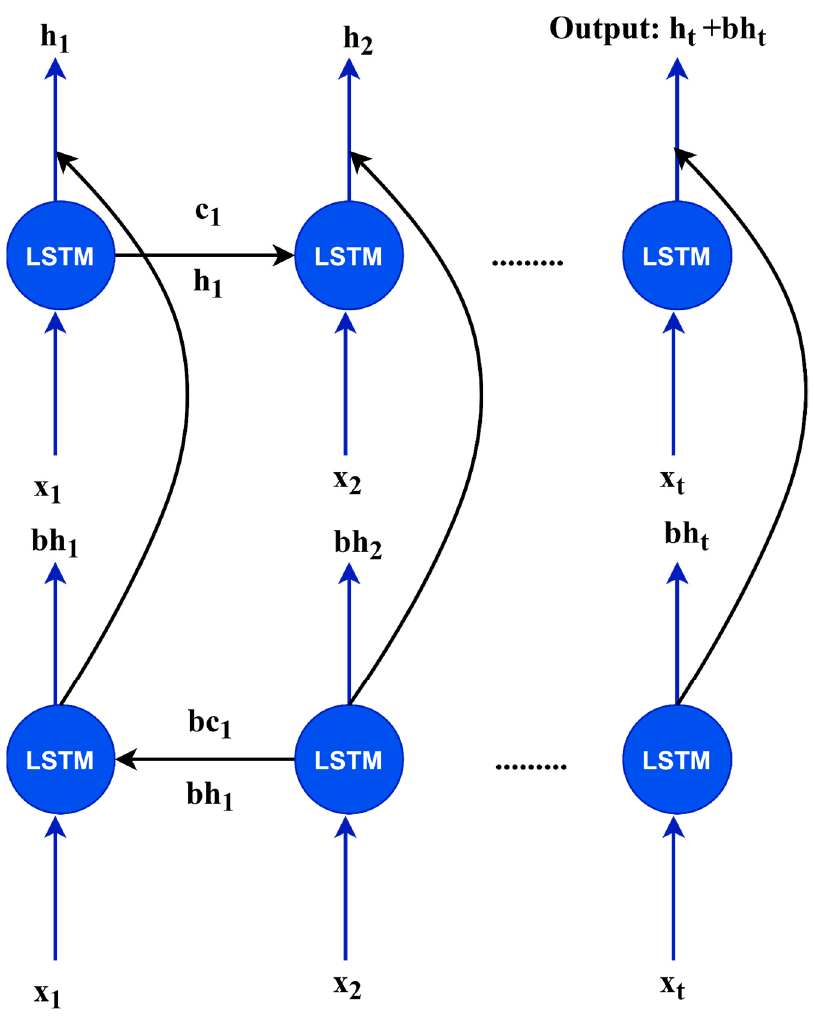
Figure 6. The architecture of bidirectional LSTM.